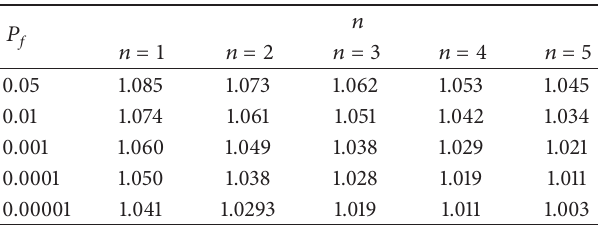
Table 3: Safety factors under different numbers of earthquakes and failure